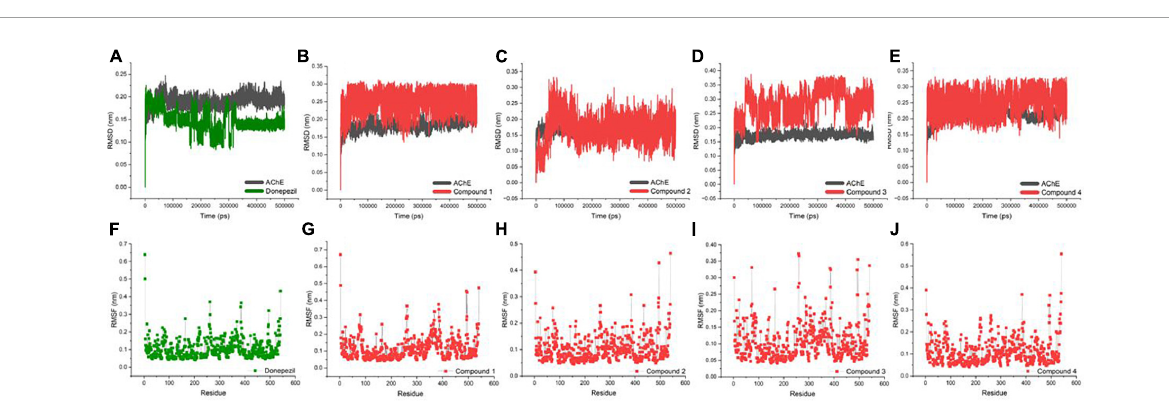
FIGURE3 Biophysical simulation analysis of the complexes. Root-mean-square deviation (RMSD) plot of AChE in complex with (A) Donepezil, (B) Compound 1, (C) Compound 2, (D) Compound 3, and (E) Compound 4; RMSF plot of AChE in complex with (F) Donepezil, (G) Compound 1, (H) Compound 2, (I) Compound 3, and (J) Compound 4.